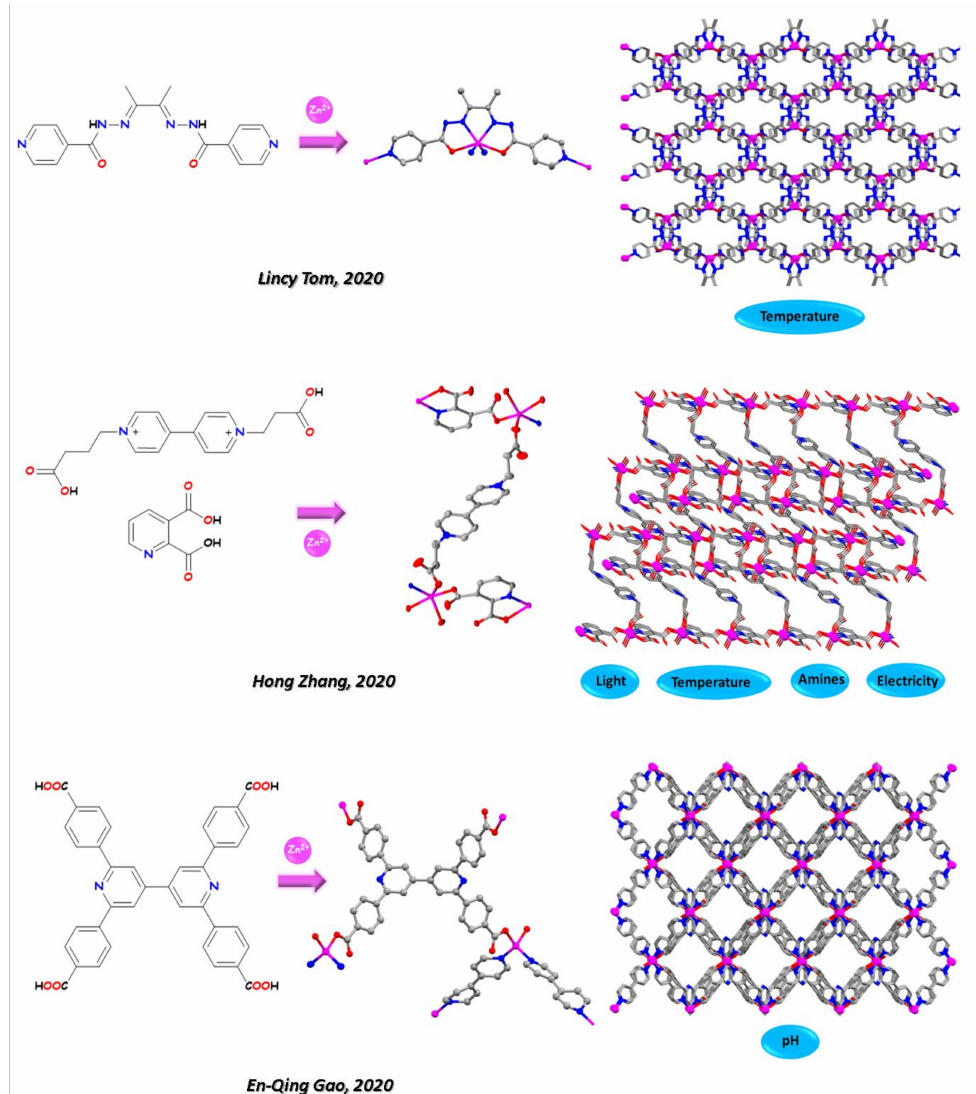
Figure 5. Some representative structures of Zn-CPs for pH and temperature sensing. Figures readapted by using Mercury software